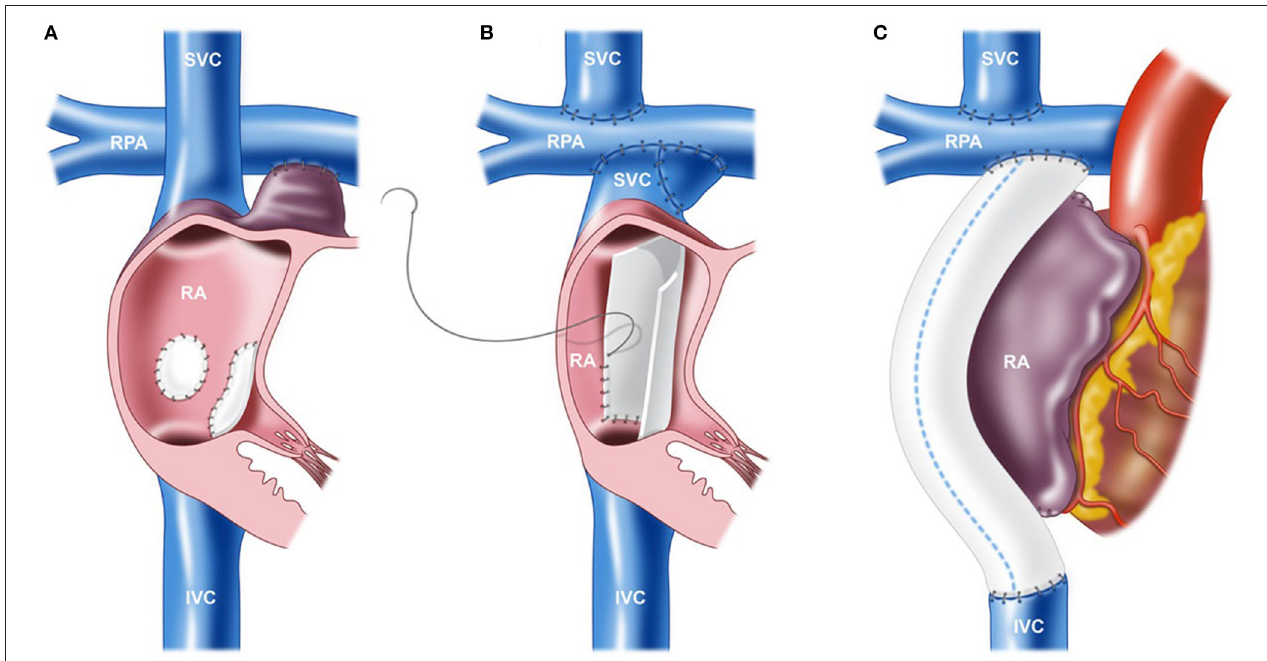
FIGURE 2 | Various techniques of the Fontan procedure. (A) Atriopulmonary connection. (B) Lateral tunnel total cavopulmonary connection (TCPC). (C) Extracardiac conduit TCPC. IVC, inferior vena cava; RA, right atrium; RPA, right pulmonary artery; and SVC, superior vena cava. Reproduced from ( 32). long-term aerobic exercise capacity (30, 31). This association